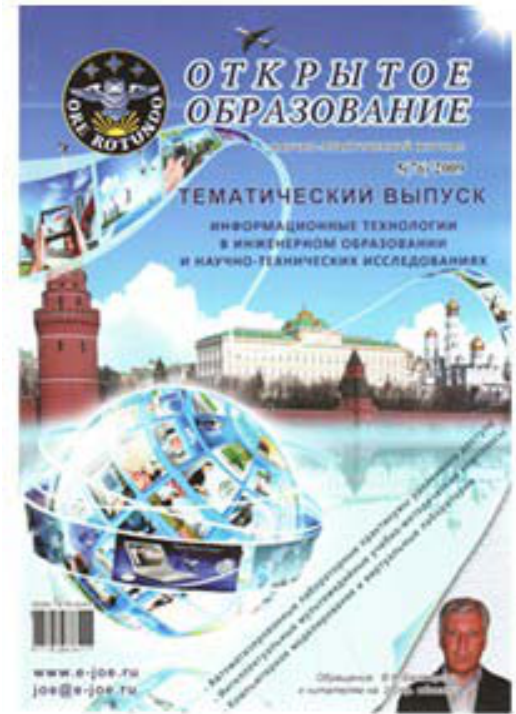
Figure 3 . Journal cover of Open Education